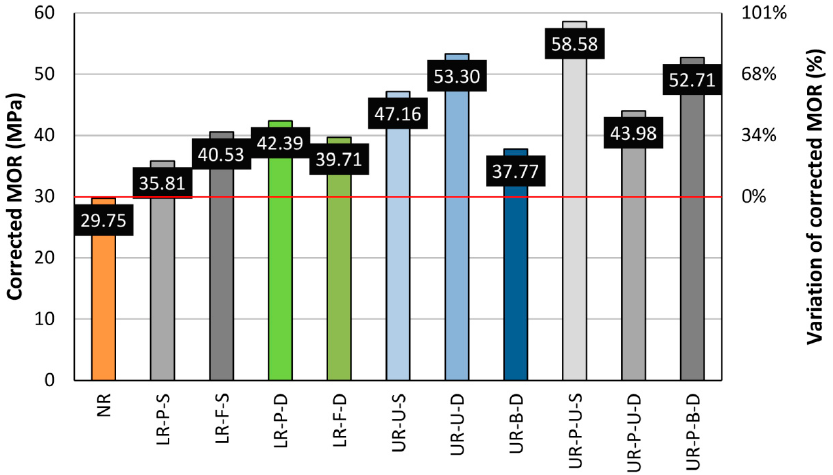
Figure 23. Average corrected MOR for each beam group. Horizontal red line. Average corrected MOR for NR beams. Materials 2017 , 10 , 1113